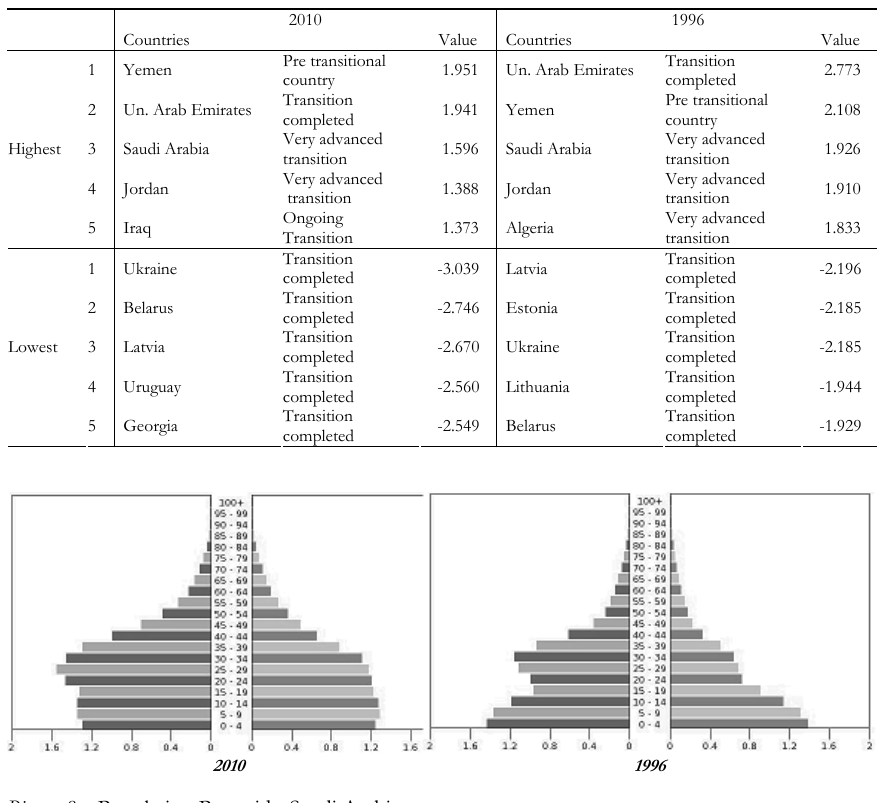
Picture 8 – Population Pyramid - Saudi